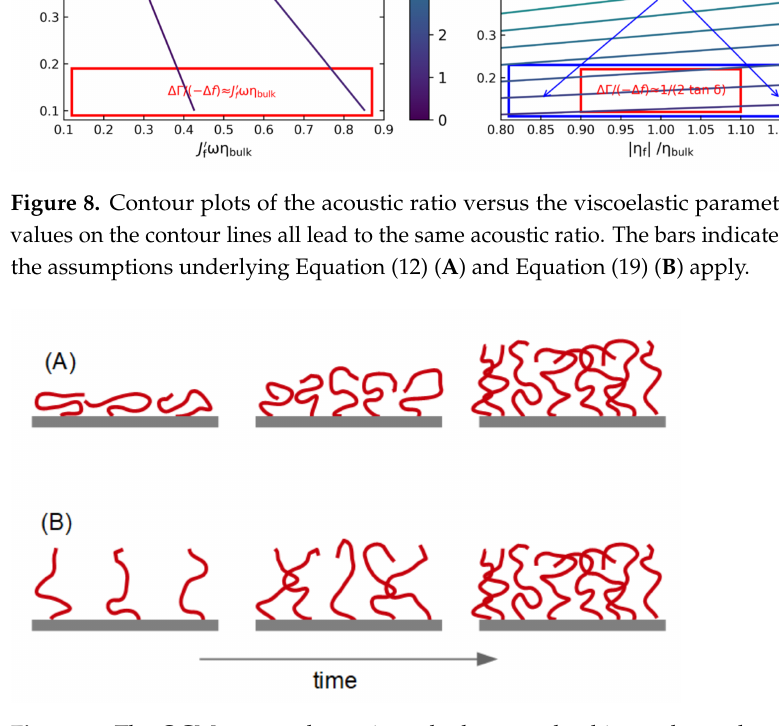
Figure 9. The QCM cannot determine whether an adsorbing polymer layer is initially thin and compact ( A ) or extended and dilute ( B ). The thickness in the later stages can be determined. The sketch is not meant to say that the configurations on the left-hand side (top and bottom) would lead to the exact same values of ∆ f / n and ∆Γ / n ; if that was the case QCM-D could determine the coverage, which it